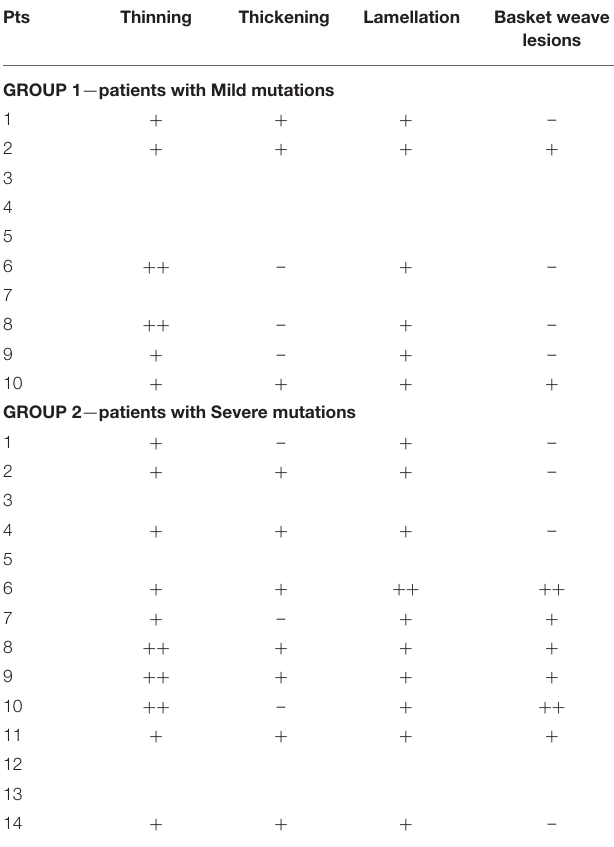
TABLE 4 | Histological ultrastructural features in our cohort of patients, where available. Pts Thinning Thickening Lamellation Basket weave